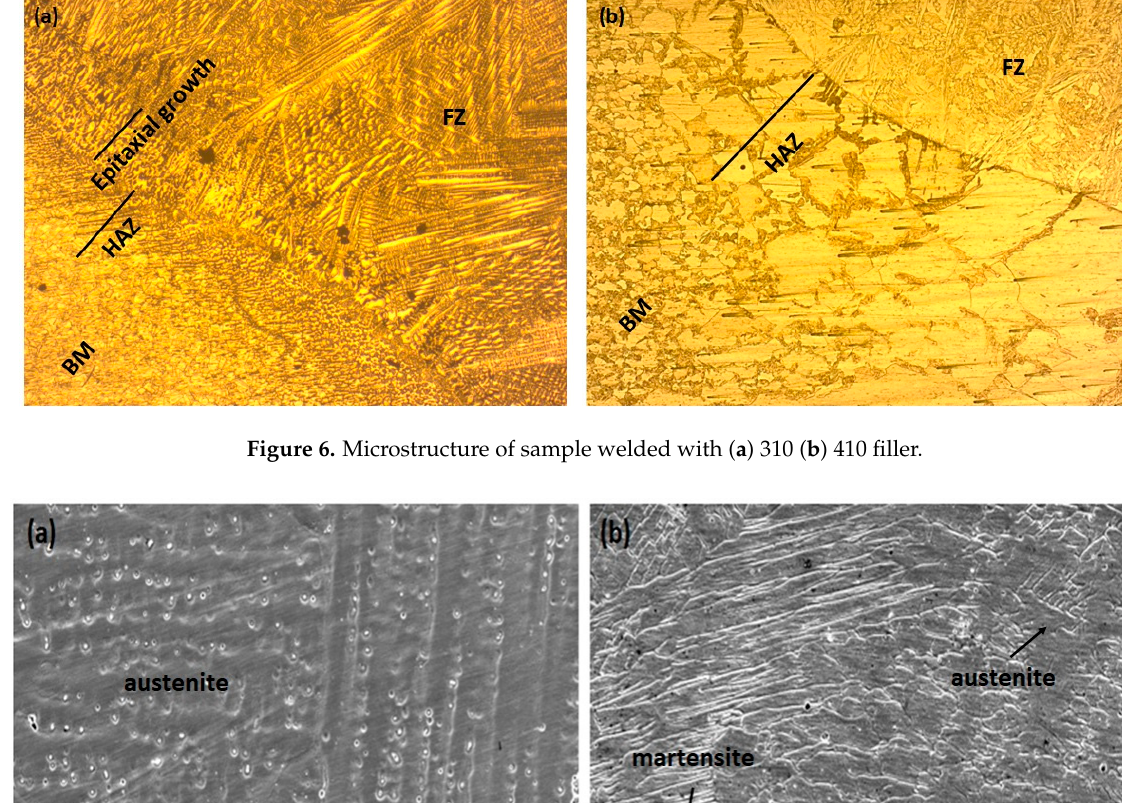
Figure 5. Optical micrograph of 430 SS.